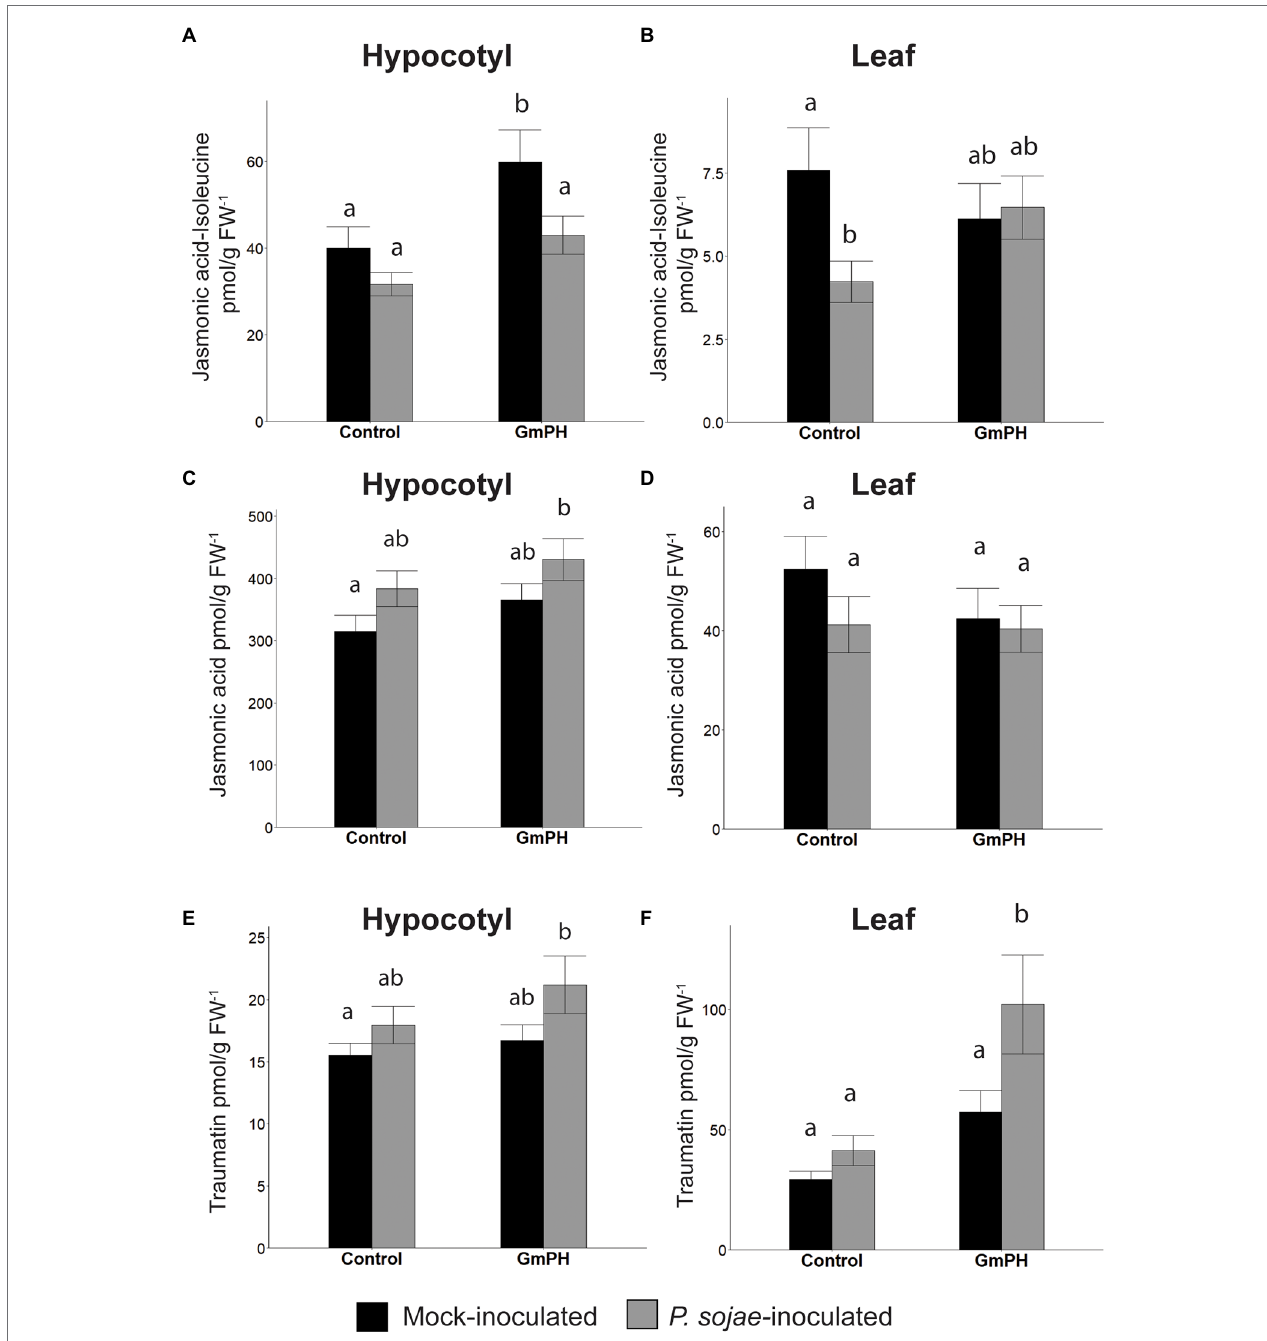
FIGURE 7 | Phytohormone levels in GmPH and Control soybean lines. (A,B) Levels of Jasmonic acid-Isoleucine conjugate in hypocotyls (A) or primary leaves (B) of control (null and Vmut) and GmPH (GmPH9#4 and GmPH23#11) lines after mock- or P. sojae inoculation. (C,D) Levels of jasmonic acid, in hypocotyls (C) or primary leaves (D) of control and GmPH lines after mock- or P. sojae inoculation. (E,F) Levels of traumatin in hypocotyls (E) or primary leaves (F) of control and GmPH lines after mock- or P. sojae inoculation. All measurements represent the average of three independent biological replicates, 12 plants pooled per replicate. Letters represent significance groups at p <